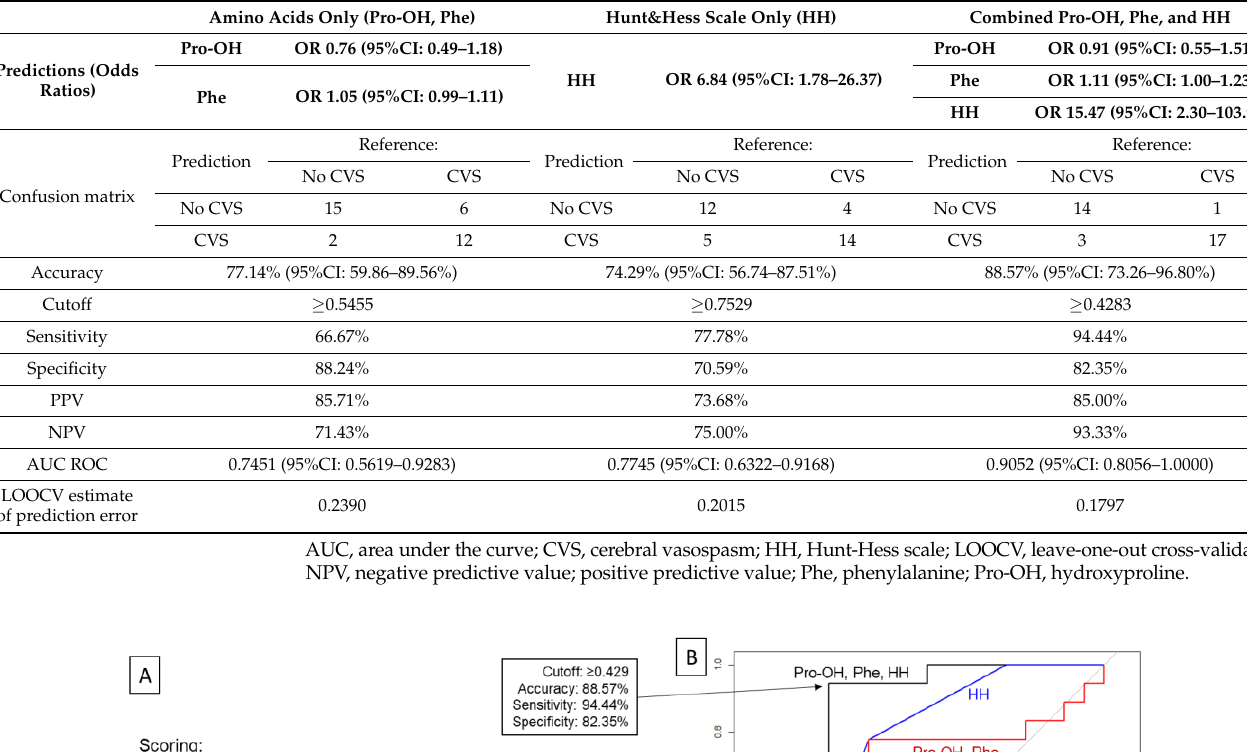
Table 5. Performance of logistic regression models.